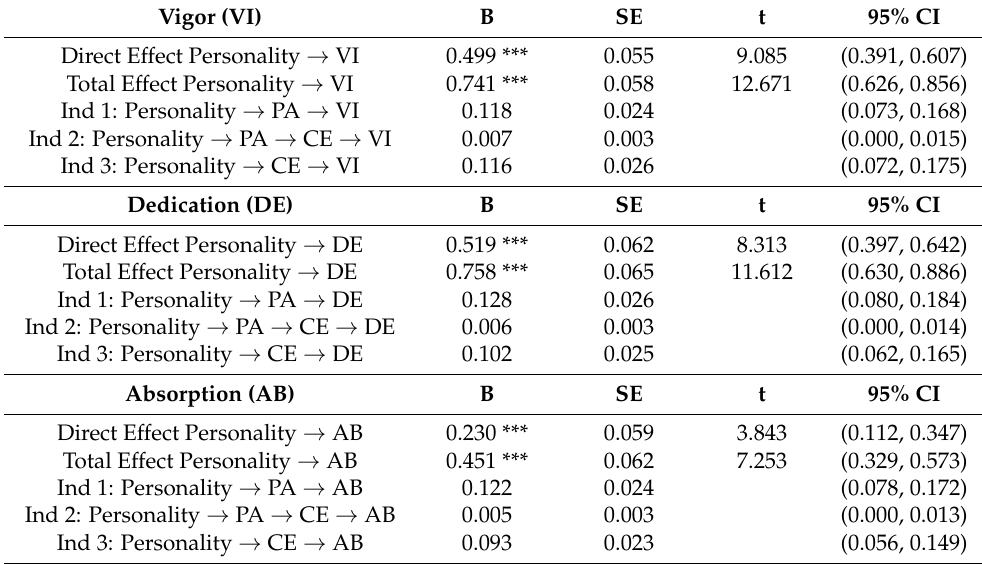
Table 3. Direct, total, and indirect effects: Vigor, Dedication, and Absorption.